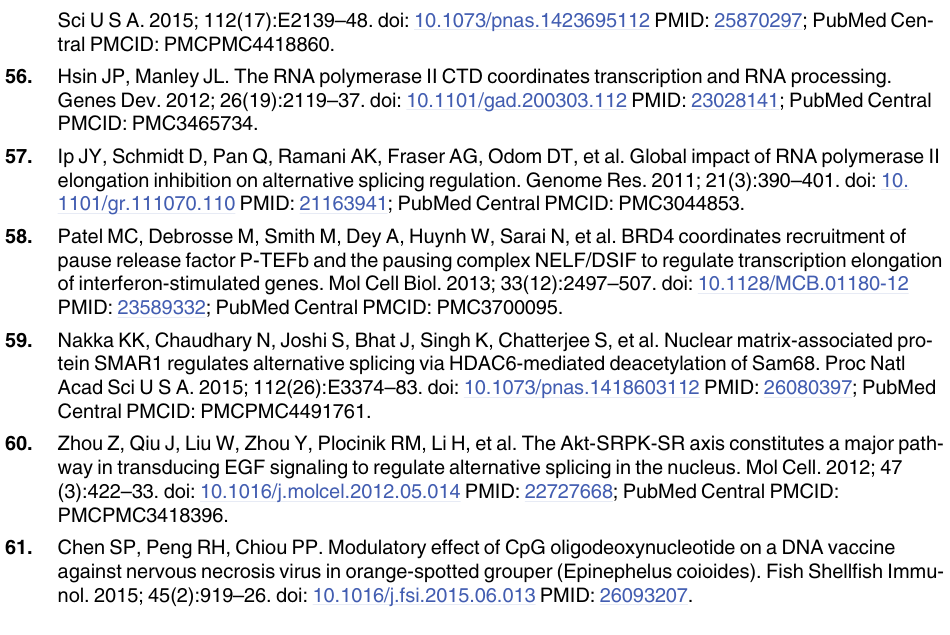
PLOS ONE | DOI:10.1371/journal.pone.0163415 September 22,